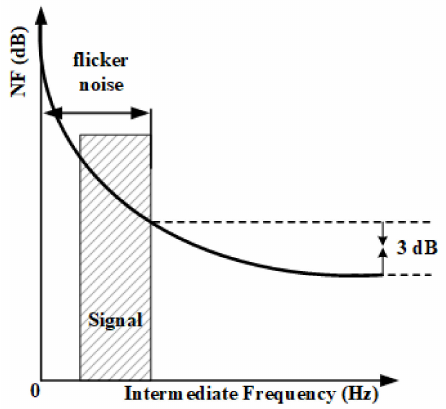
Figure 2. Baseband signal degraded by flicker